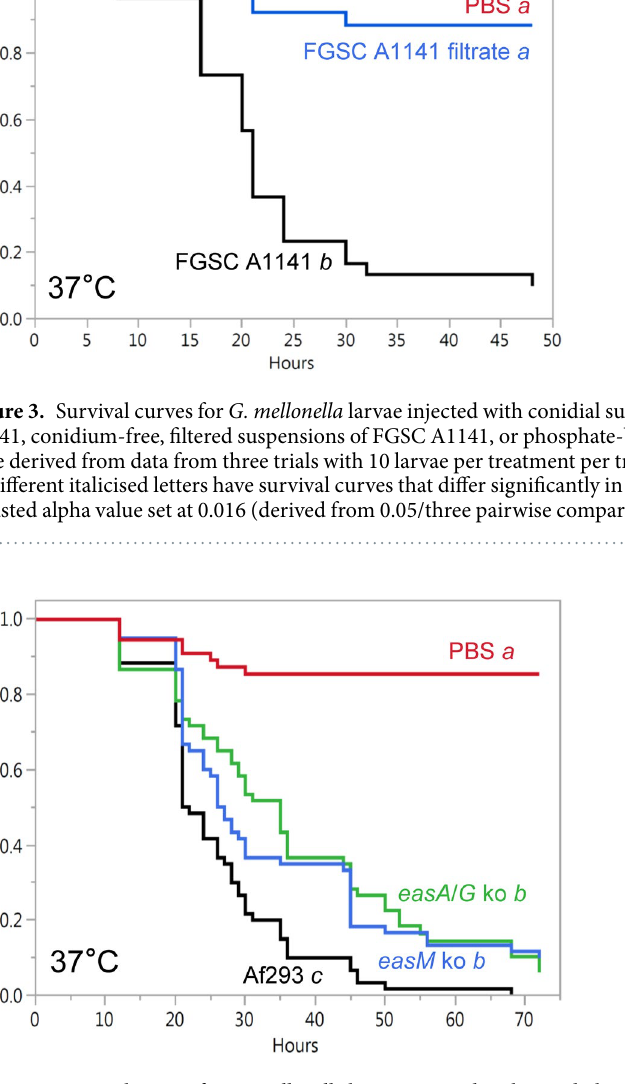
Figure 4. Survival curves for G. mellonella larvae injected with conidial suspensions of N. fumigata Af293, an easM knockout (ko) of strain Af293, an easAG ko of strain Af293, or phosphate-buffered saline control (PBS). Curves are derived from data from four trials with 15 larvae per treatment per trial. Treatment labels followed by different italicised letters have survival curves that differ significantly in a log-rank test with Bonferroni- adjusted alpha value set at 0.0083 (derived from 0.05/six pairwise